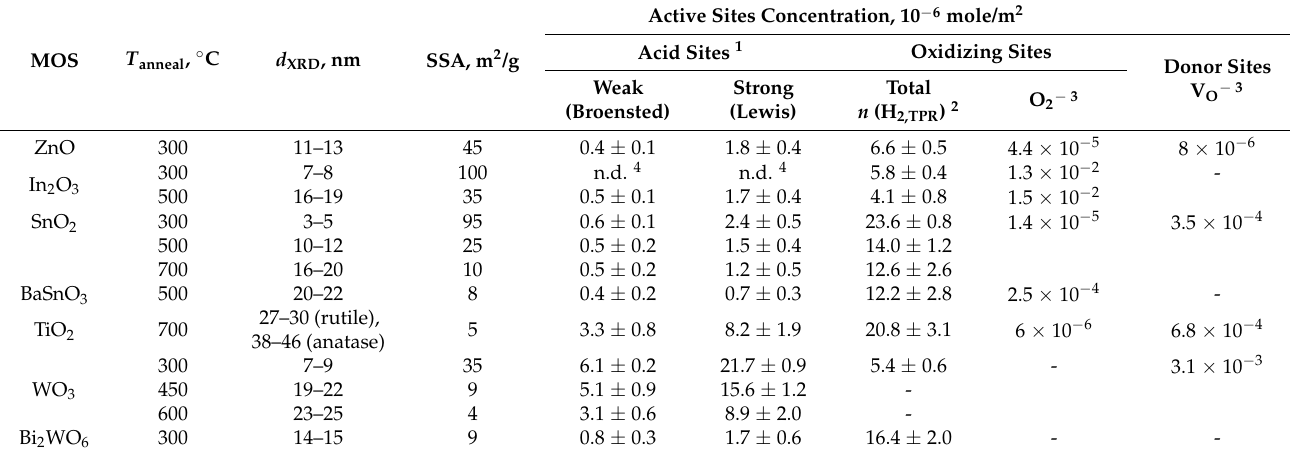
1 Evaluated by TPD of ammonia. 2 Evaluated by TPR with hydrogen. 3 Evaluated by EPR. 4 No data for TPD from In 2 O 3 annealed at 300 °C because of ammonia oxidation caused by residual nitrate species [78,97].